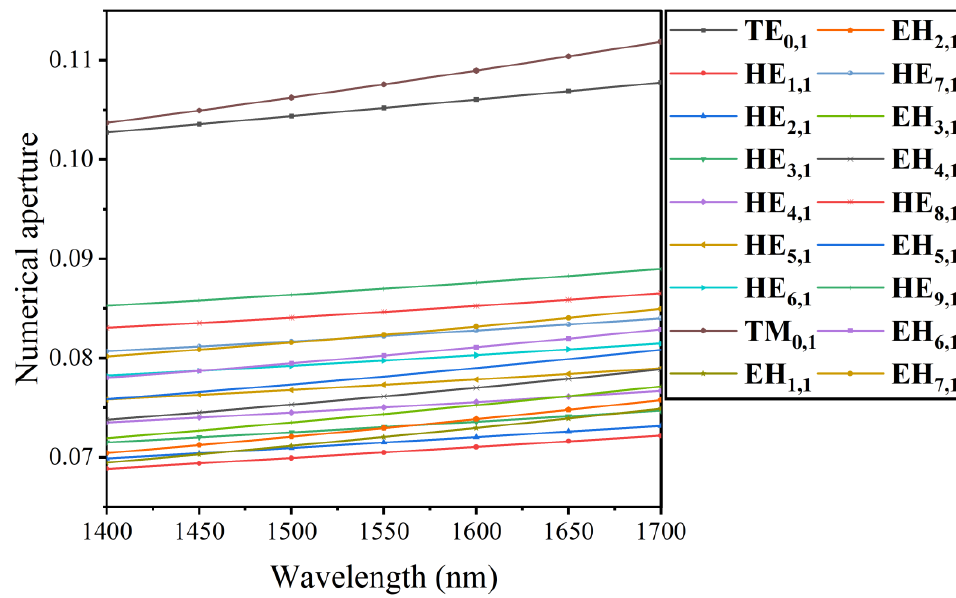
Figure 11. The relation between NA and wavelength in different vector modes.